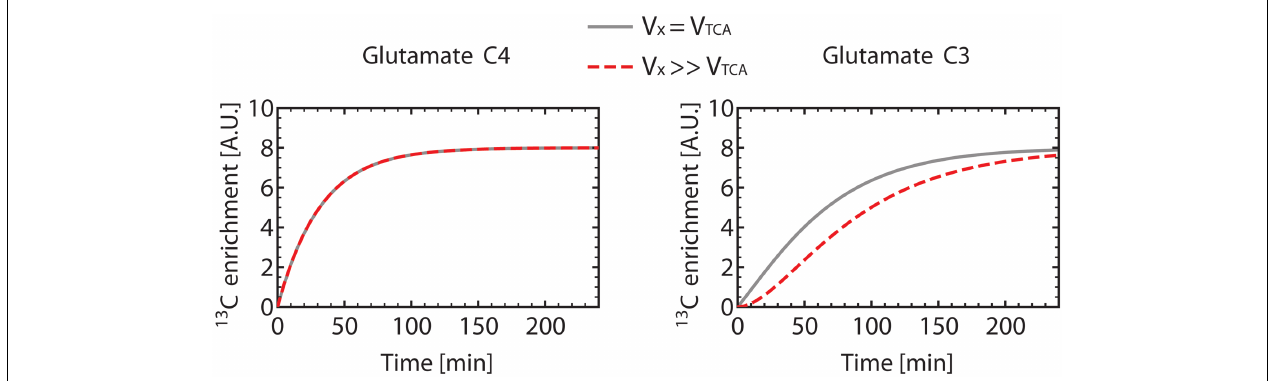
FIGURE 6 |Turnover curves of the carbon position C4 and C3 of glutamate as simulated using the one-compartment model (Figure 4) with a constant V gt . For the gray turnover curves, V X was set equal to V TCA ( V X = V TCA = 0.5 µ mol/g/min), resulting in a non-zero slope of the glutamate C3 curve at t = 0. For the dashed red turnover curves, V X was set much larger (about 200 times) than V TCA ( V X = 50 µ mol/g/min, V TCA = 0.251 µ mol/g/min),